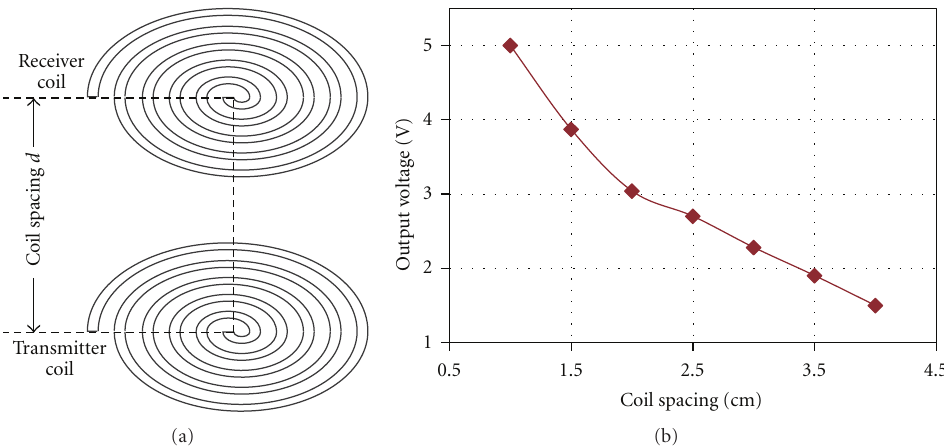
Figure 9: E ff ect of variation of coil spacing between transmitter and receiver coils: (a) orientation of the coils (b) variation of the output voltage with increase in coil spacing.